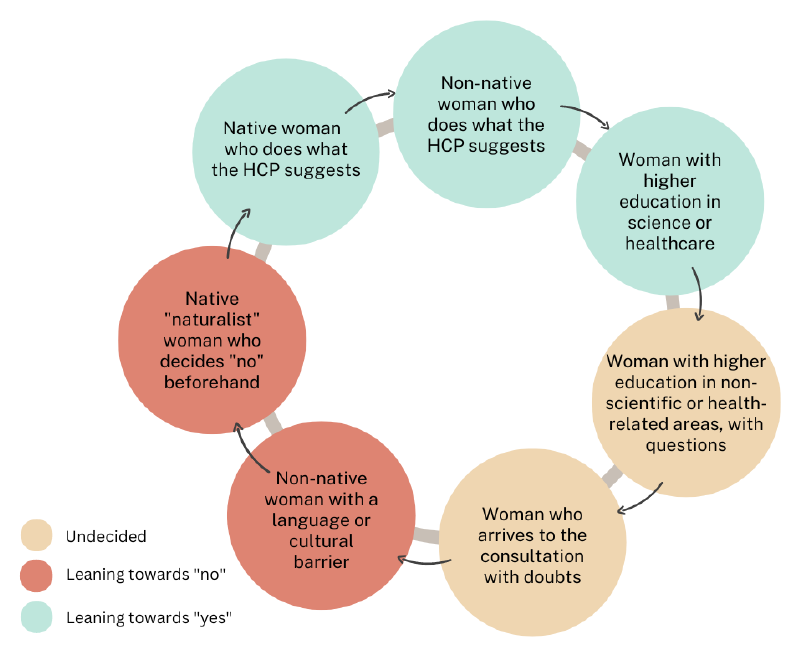
Figure 2. Profiles of pregnant women concerning maternal vaccination.